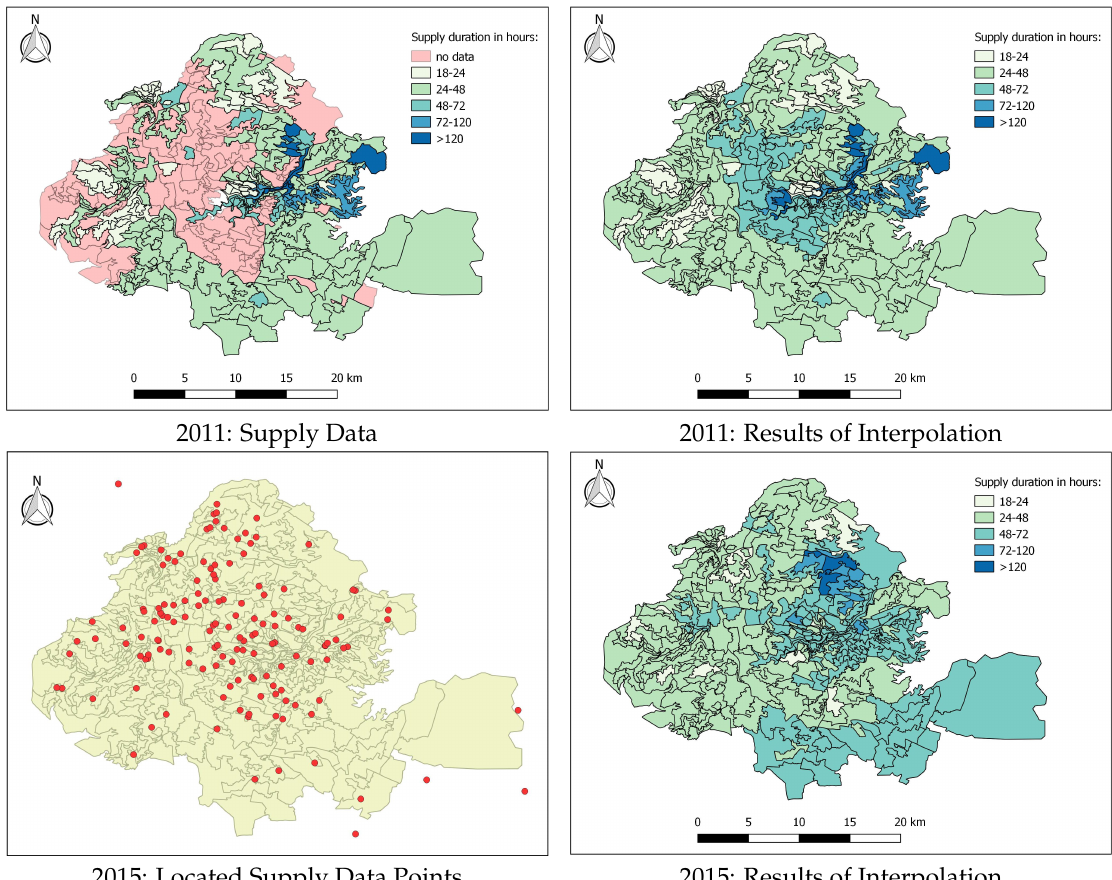
Figure 2. Network water supply durations per week in Amman for the years 2011 and